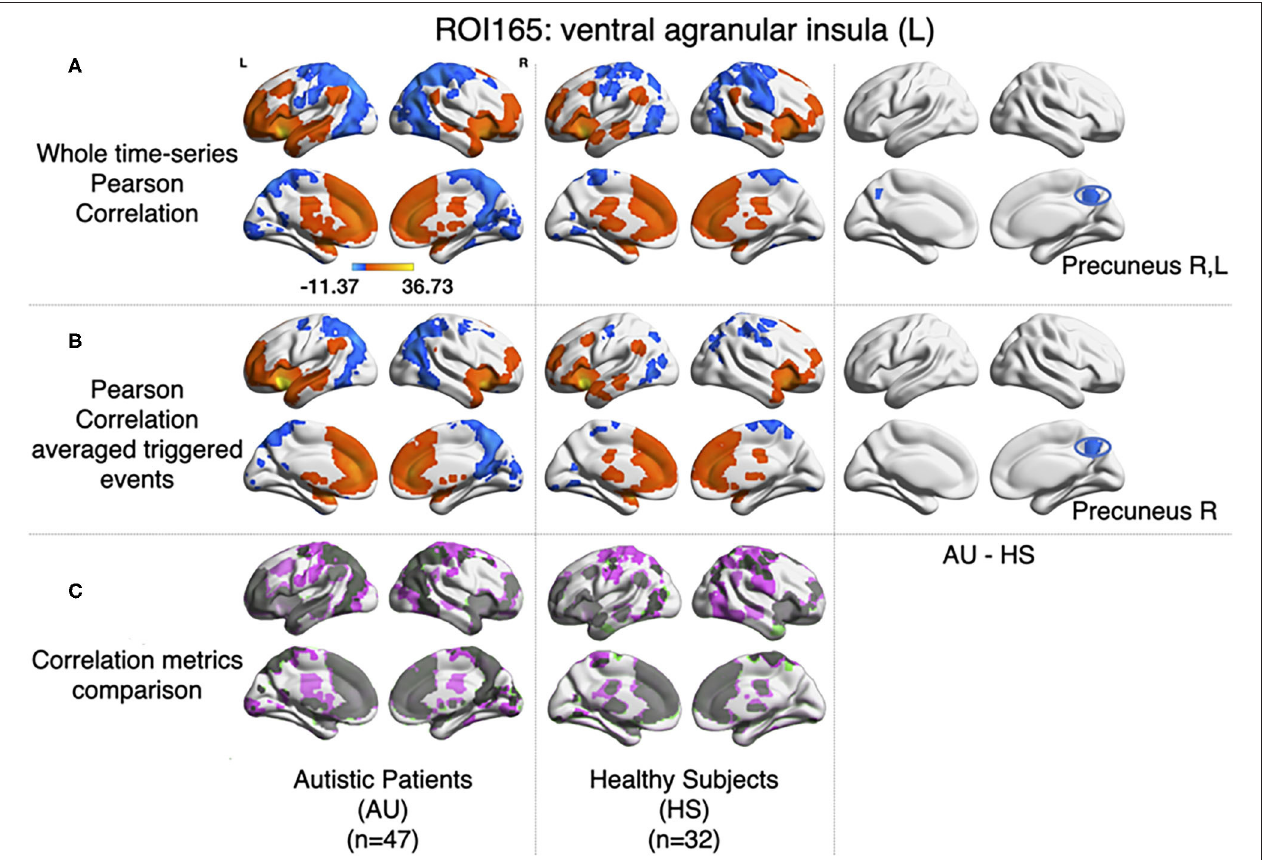
FIGURE 5 | Comparison between Pearson’s correlation of the BOLD time series and the correlation of the large amplitude BOLD events. (A) Results for zero-lag seed-voxel correlations using the left ventral agranular insula as seed. It is shown the Z-transformed Pearson’s correlation one-sample t -test for each group of participants (first-second columns for AU and third-fourth for HS) and two-sample t -test to assess differences between groups (fifth and sixth columns of brain surfaces) (GFR corrected voxel p < 0.001, cluster p < 0.05). (B) The same distribution of columns as (A) , for the results of correlating the large events (Z-transformed, GFR corrected voxel p < 0.001, cluster p < 0.05). (C) Correlations from A and B compared, gray areas show coincidences between metrics, pink shows correlations only detected in A and green correlations only detected in (B)